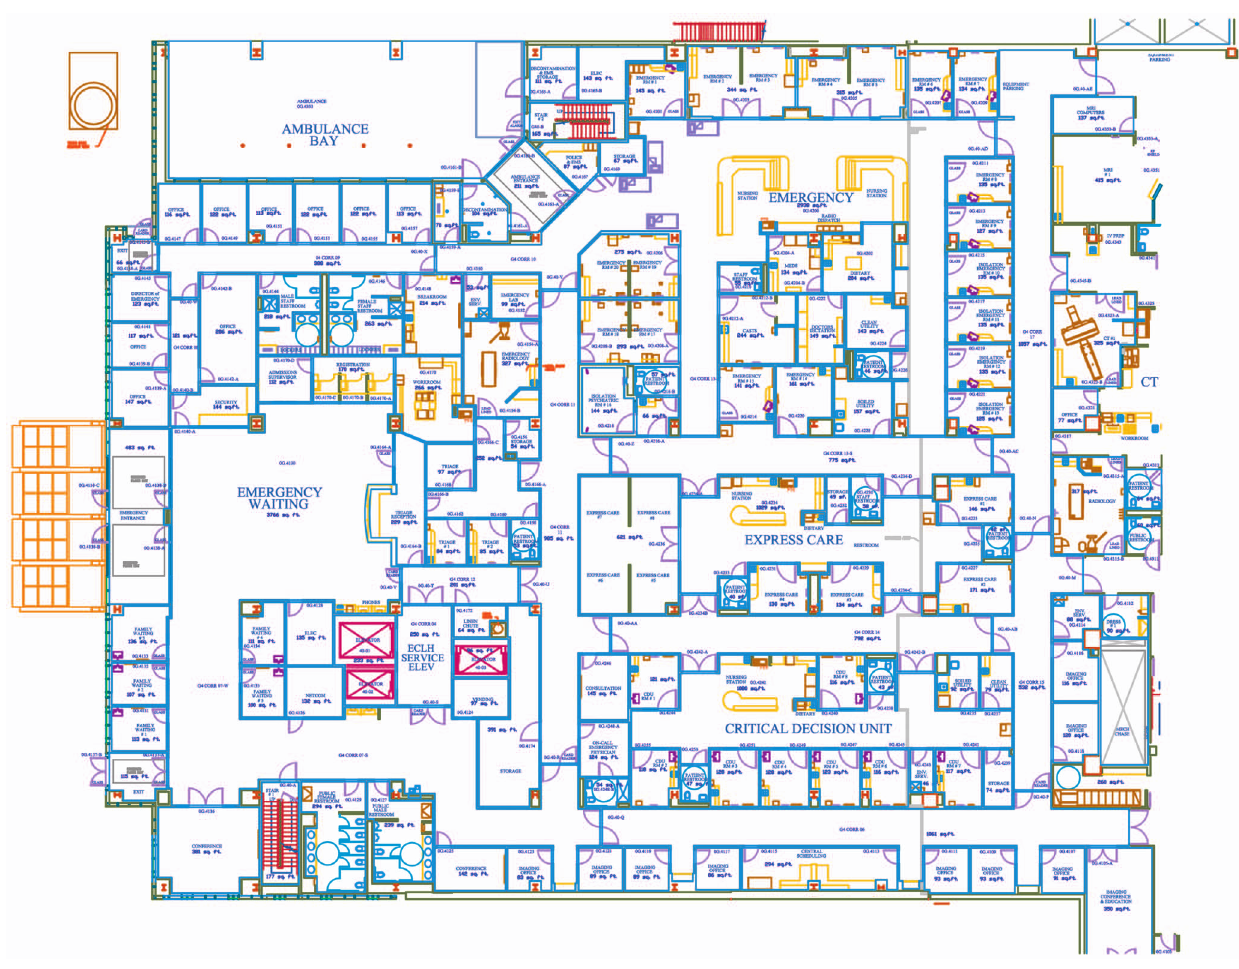
Figure 1. Floor plan of ED at EUHM. Red dots indicate RFID sensors. Zones are numbered and outlined in blue.